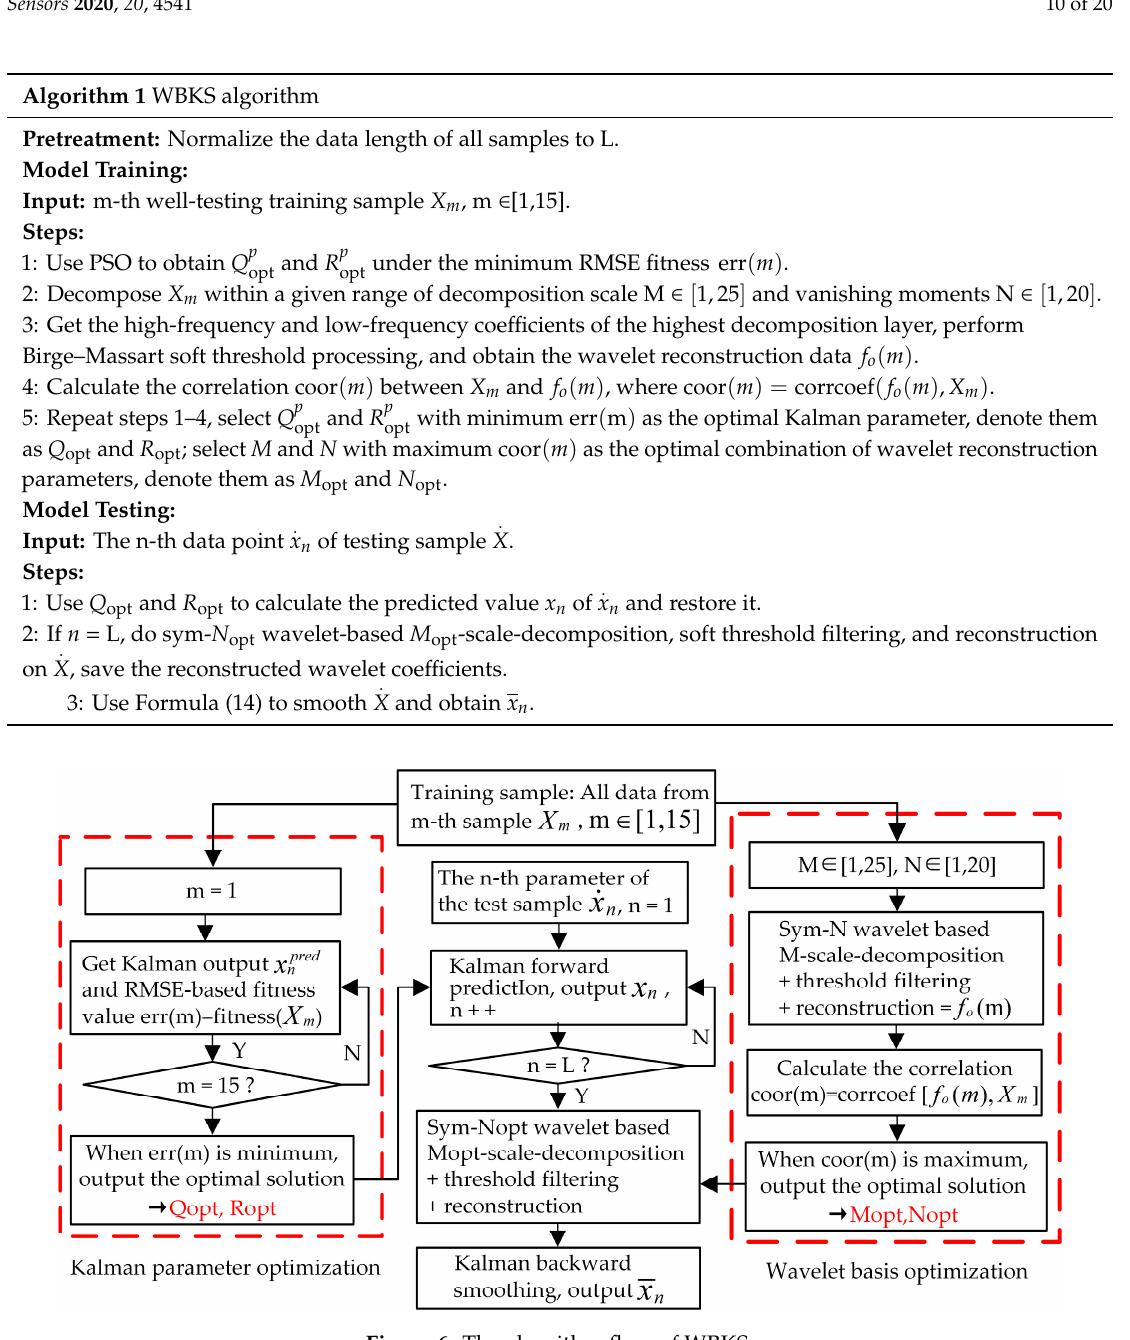
Figure 6. The algorithm flow of WBKS.